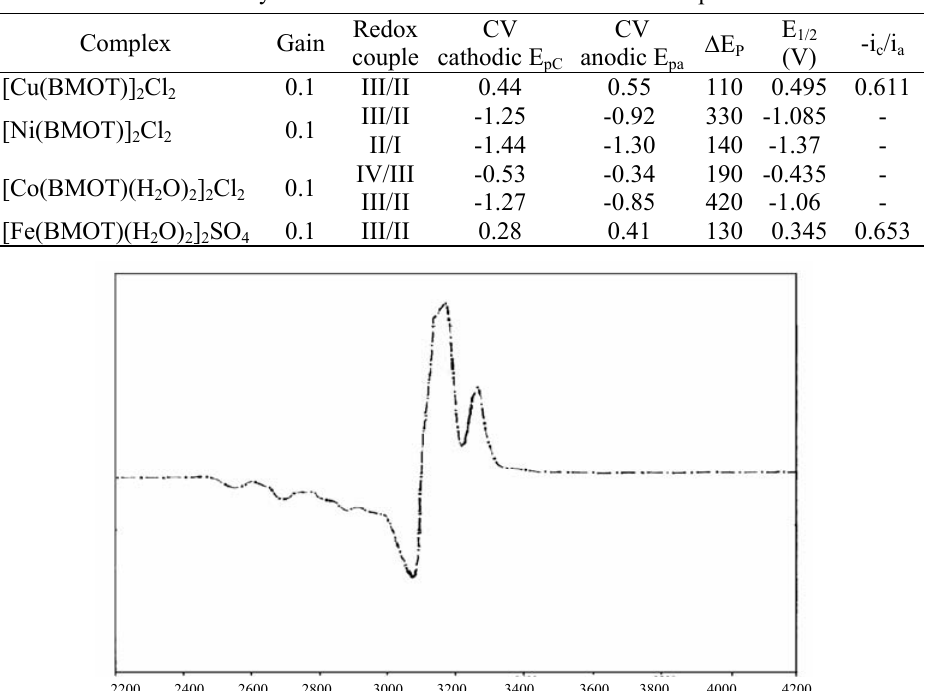
Figure 1. X-band ESR spectrum of [Cu(BMOT)]